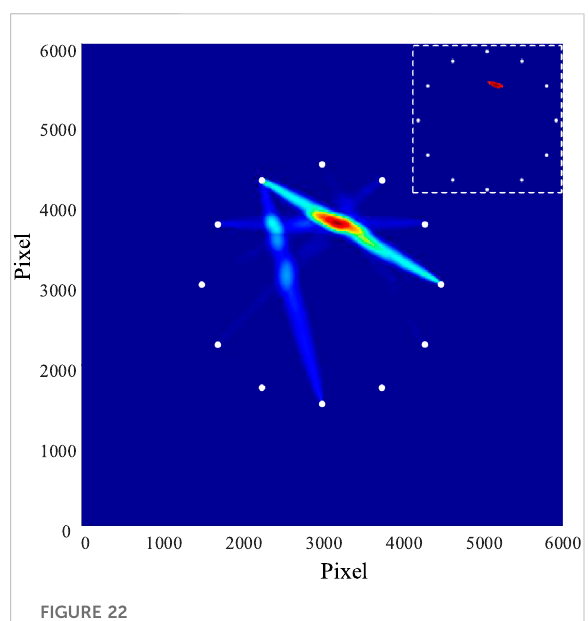
FIGURE 22 Single damage imaging results in strong noise